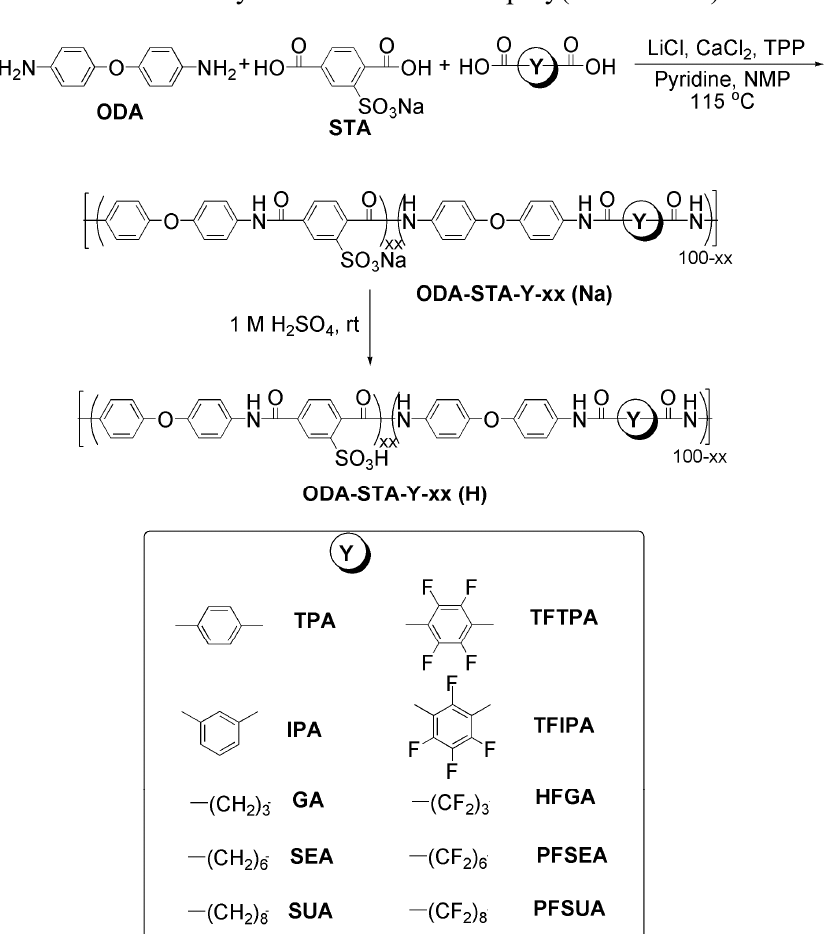
Scheme 1. Synthesis of sulfonated poly(ether